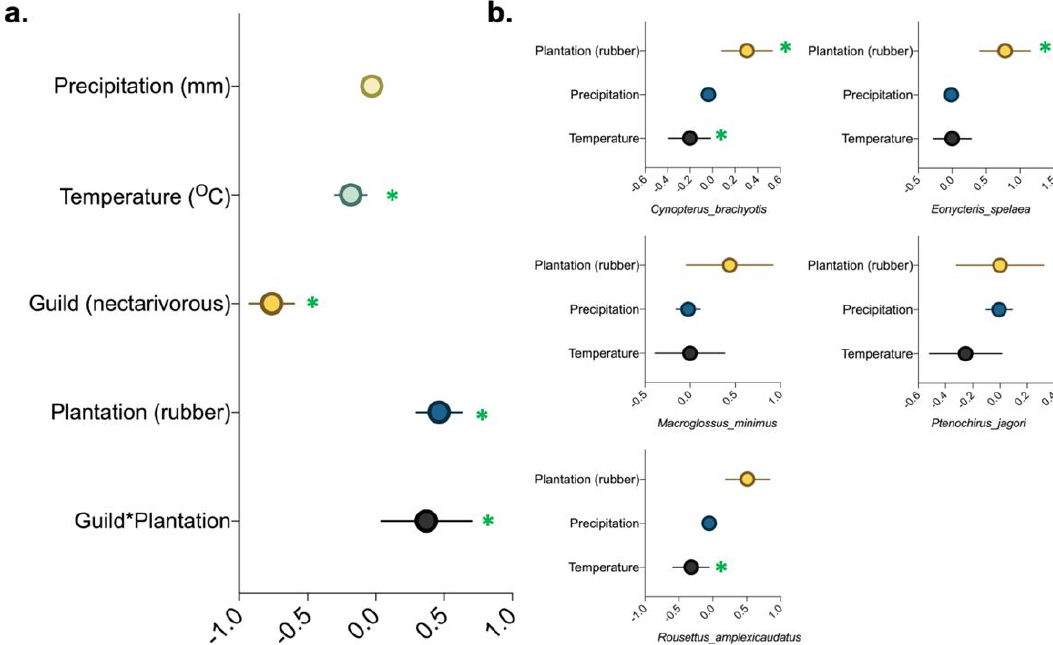
Figure 5. Visualised response of overall bat abundance ( a ) and species-specificities ( b ) to climatic variables (temperature and precipitation), plantation type, and guild. The * indicates significance at p < 0.05.